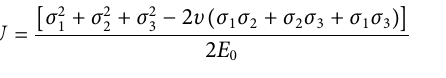
Frontiers in Earth Science |